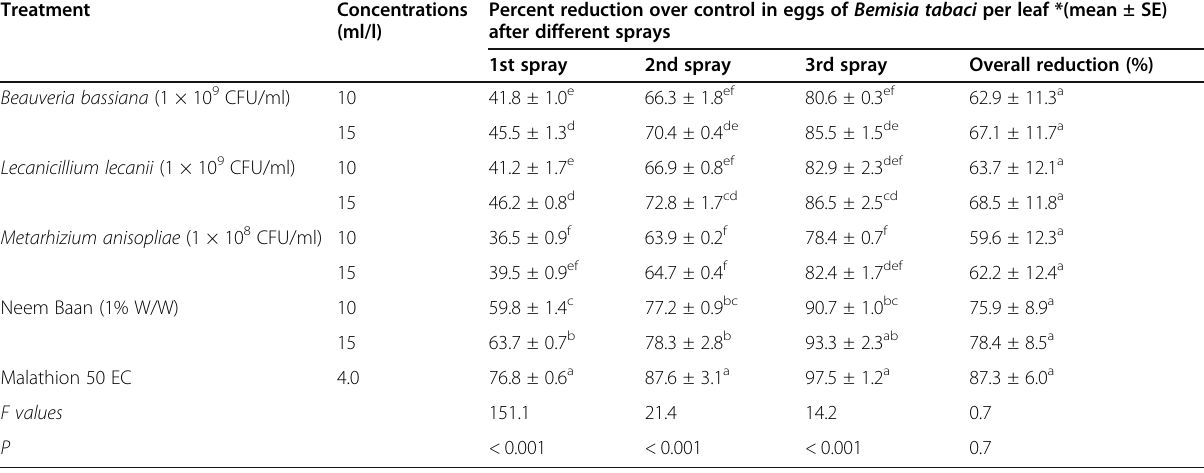
Table 2 Efficacy of different biopesticides against eggs of Bemisia tabaci on cucumber under net house conditions during autumn cropping season (2017)